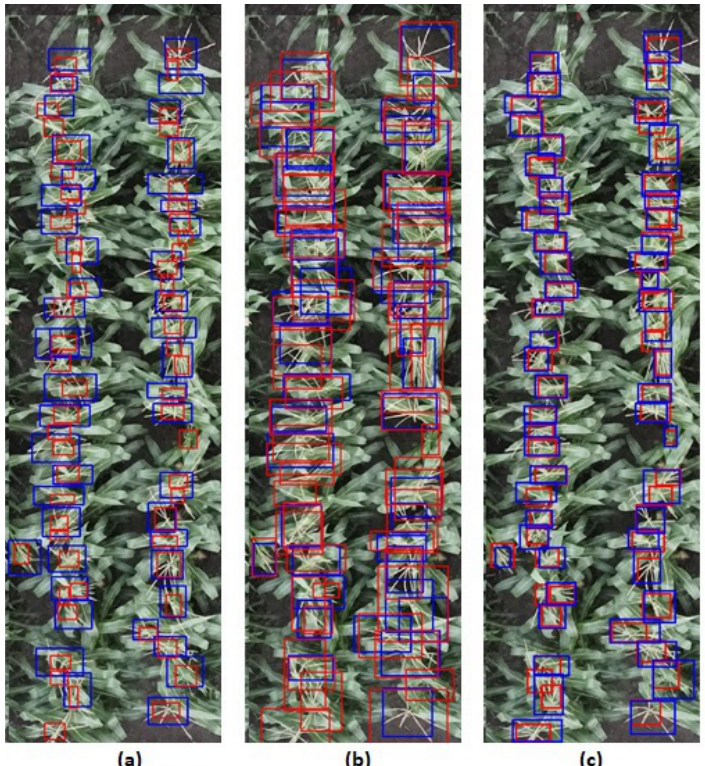
Figure 10. Bounding box annotation with different sizes (Red: Ground truth, Blue: Detected tassels); ( a ) Small; ( b ) Large; ( c ) Correct size.